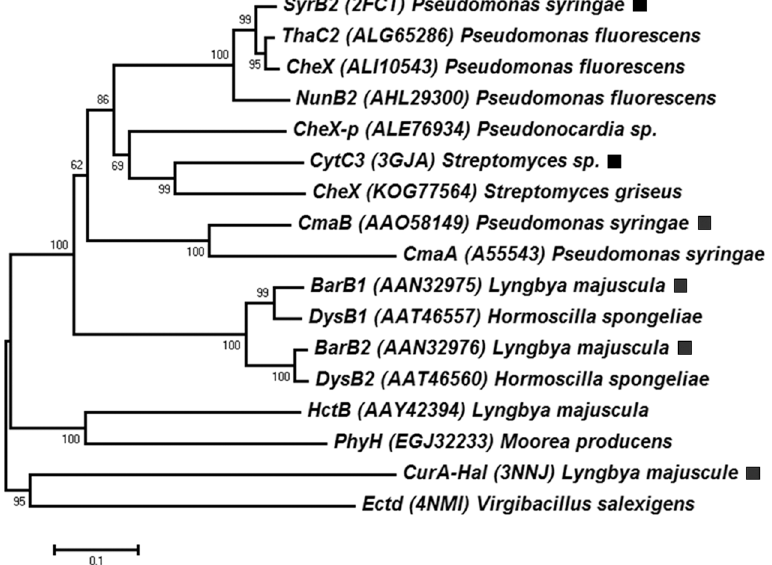
Fig 3. Evolutionary relationships between the NI-HG and the chemotaxis phosphatases. The phylogenetic tree was reconstructed using the Neighbor-Joining method. The representative NI-HG enzymes are marked ( &